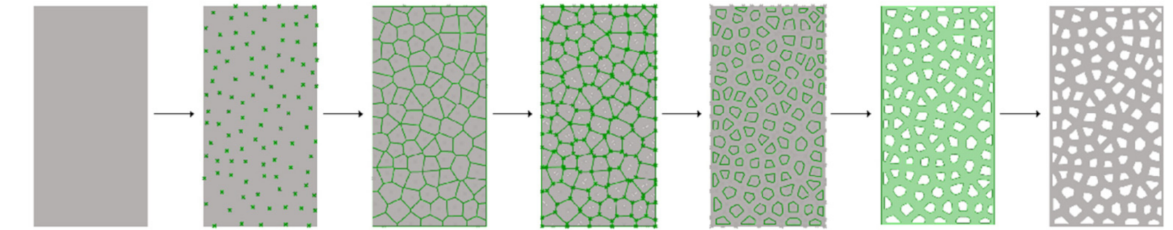
Figure 7. Parametric modeling process of the Voronoi